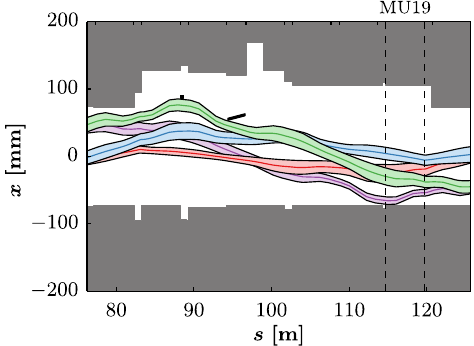
FIG. 23. Simulated horizontal orbits of the islands with the amplitude of the slow bump being at its maximum. The envelopes represent a beam size with extension of 3 σ x and 2 σ s , based on ¼ 5 mm mrad, Gaussian distributions in both planes ( ε n x ð 1 σ Þ ¼ 5 × 10 − 4 ). The horizontal mechanical aperture is Δ p=p ð 1 σ Þ represented in gray. The two septa are closely approached and the actual aperture limitation is caused by the proximity of the beam to the vacuum chamber inside MU19. FIG. 24. Top: Signal of the fast BLM16. The grey area indicates a duration of five turns, with the dashed lines being separated by one turn. The red and the blue circles correspond to the maximum beam loss occurring during the extraction of the islands and the core, respectively. Bottom: Dependency of beam loss on the position of SMH16 for an angle of 0 mrad. Red and blue circles correspond to the losses of the islands and the core, respectively, and the black circles represent their sum. Error bars describe the standard deviation obtained over 10 consecutive measurements. The dashed line and the grey band indicate mean value and standard deviation of losses for the nominal septa